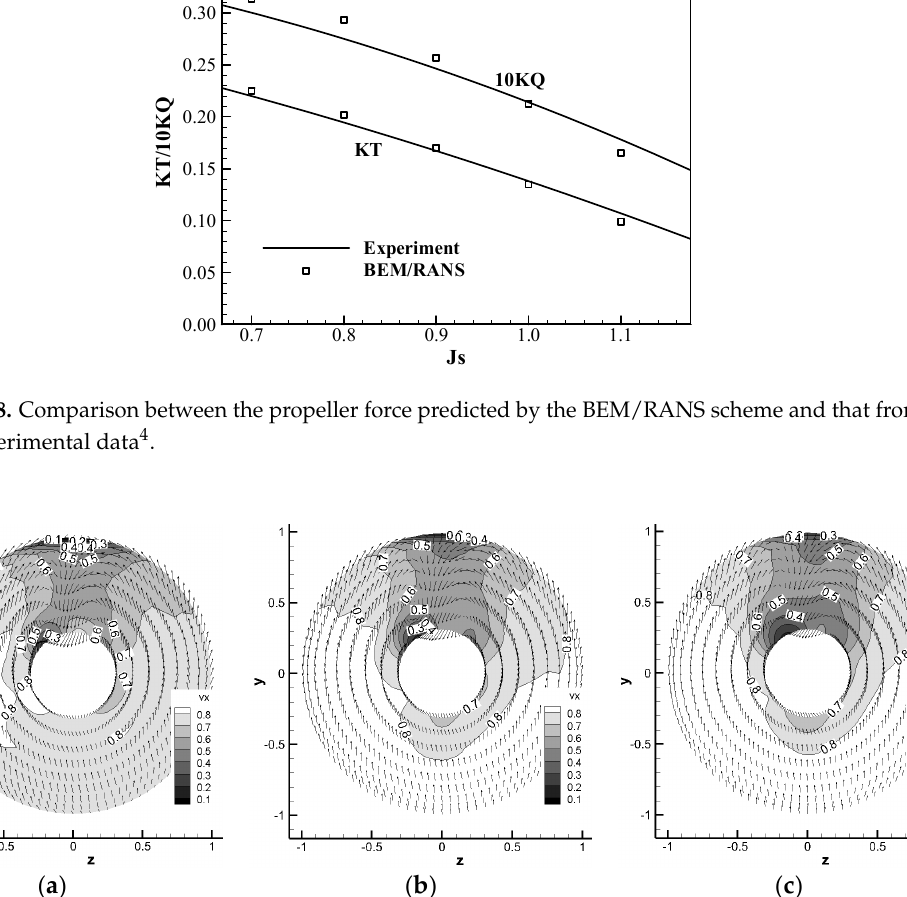
( c ) Figure 10. Comparison of steady wake geometry and unsteady blade wake geometries at different blade angles. The blade-angle ranges between 0 and 2 π and is defined by the angle the blade has passed starting from the “upright position”. The “upright position” means the mid-camber point of the root section is located on the vertical axis above the hub (+ y axis). ( a ) steady wake; ( b ) unsteady wake 0 degrees; ( c ) unsteady wake 180 degrees. Please note the wake is shown relative to the propeller fixed system. So the hull is physicallly located above the propeller in ( b ), but “below” the propeller in ( c ). Thus, in both cases, ( b ) and ( c ), the propeller wake appears to be aligned in a direction parallel to the hull surface.